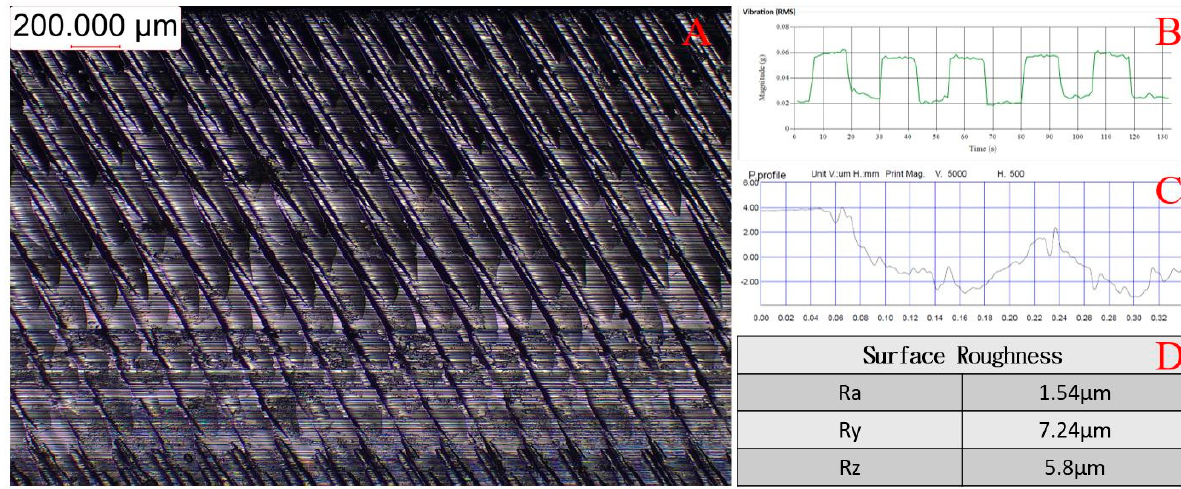
Figure 19. D5-measurement result of Parameter 1.